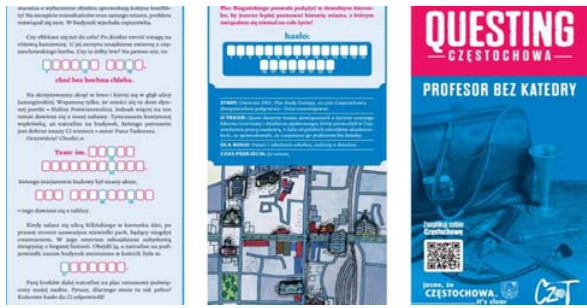
Fig. 2. “Profesor bez katedry” questing